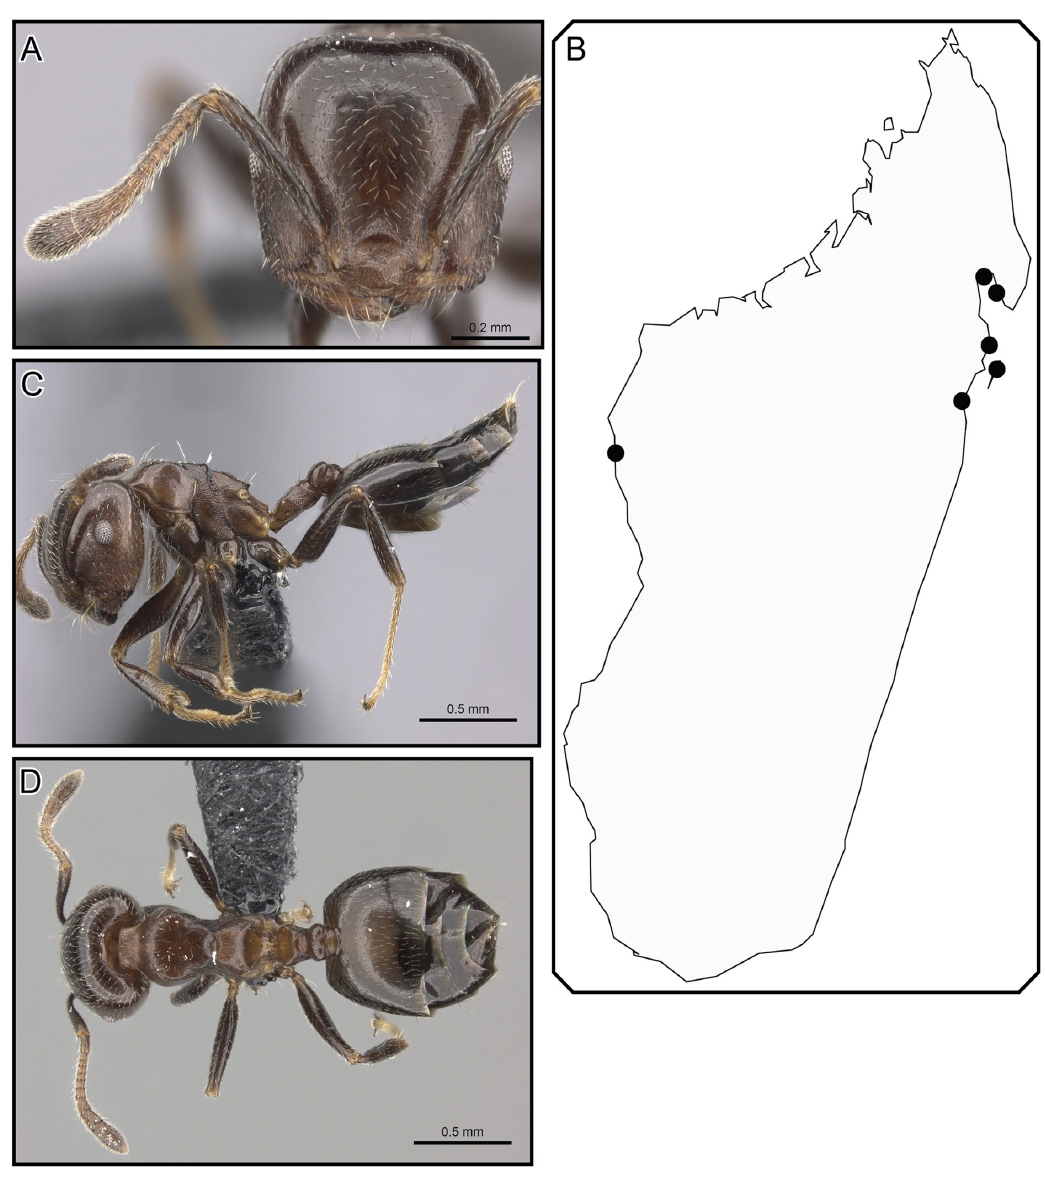
Fig. 18. Crematogaster masokely sp. nov., worker and distribution. A, C-D. Worker (CASENT0068954). A. Full-face. C. Profile. D. Dorsal. B. Species